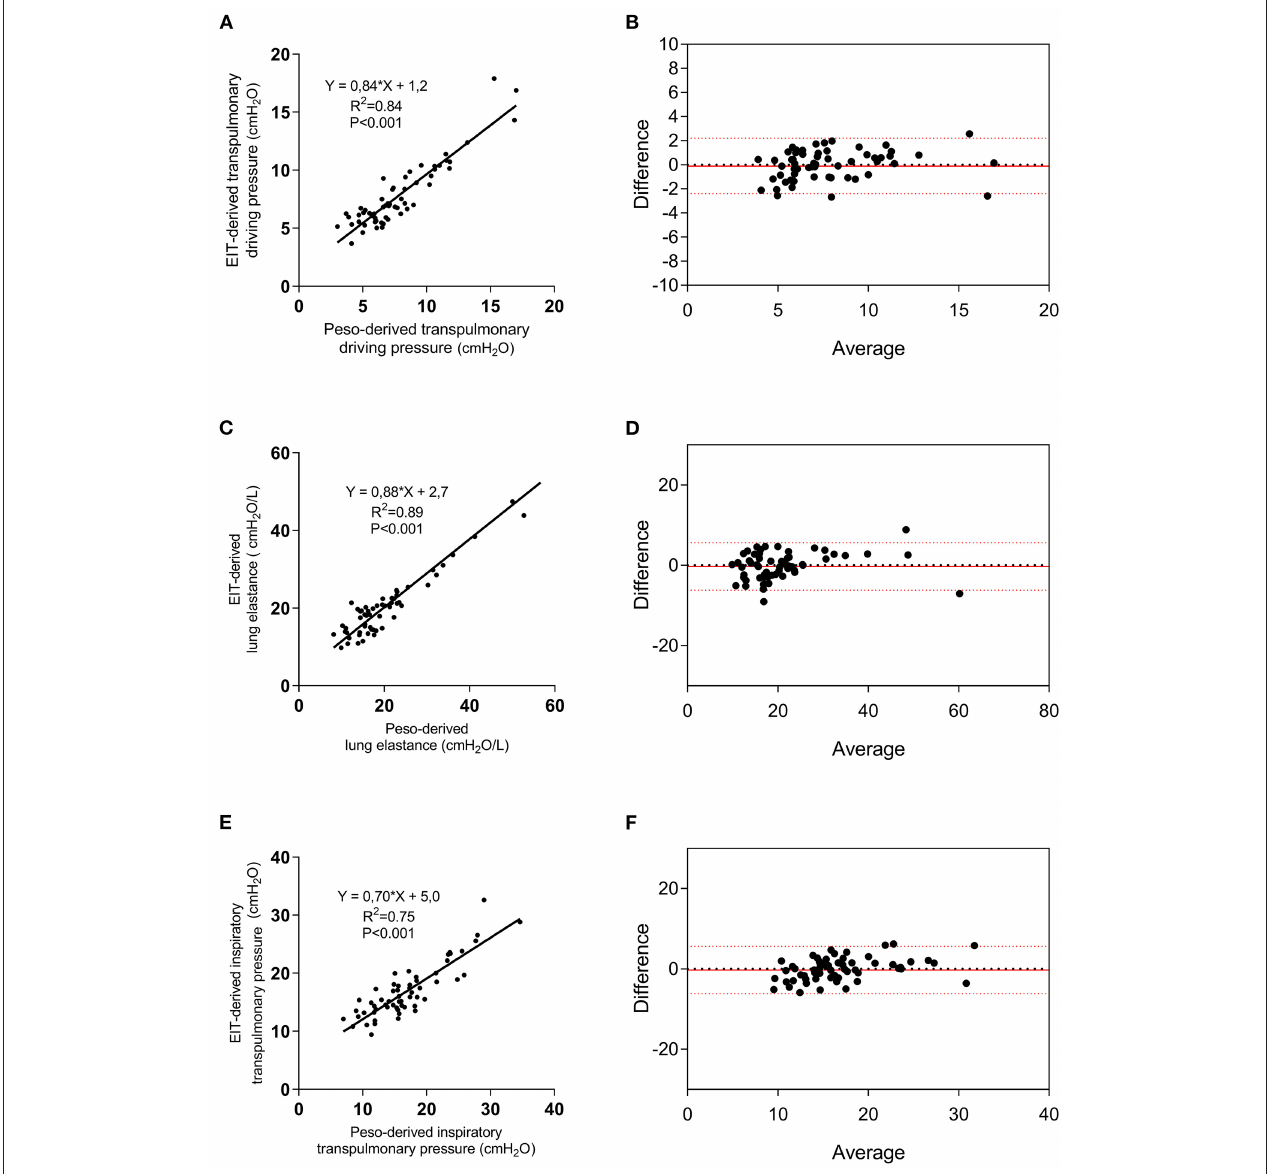
FIGURE 2 | Electrical impedance tomography derived and measured DP L , lung elastance (EL), and elastance-derived inspiratory lung pressure. Linear regression between EIT-derived and measured DP L (A) , EL (C) , and lung inspiratory pressure (E) , and relative Bland-Altmann plots (B,D,F) . EIT, electrical impedance tomography; Peso, esophageal